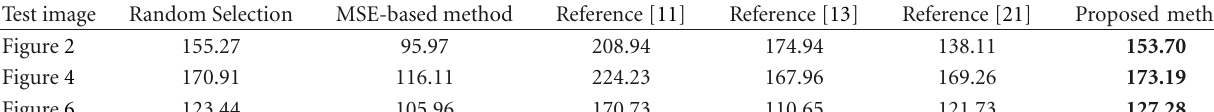
Table 1: Performance comparison (MSE) of the proposed method and the conventional methods.